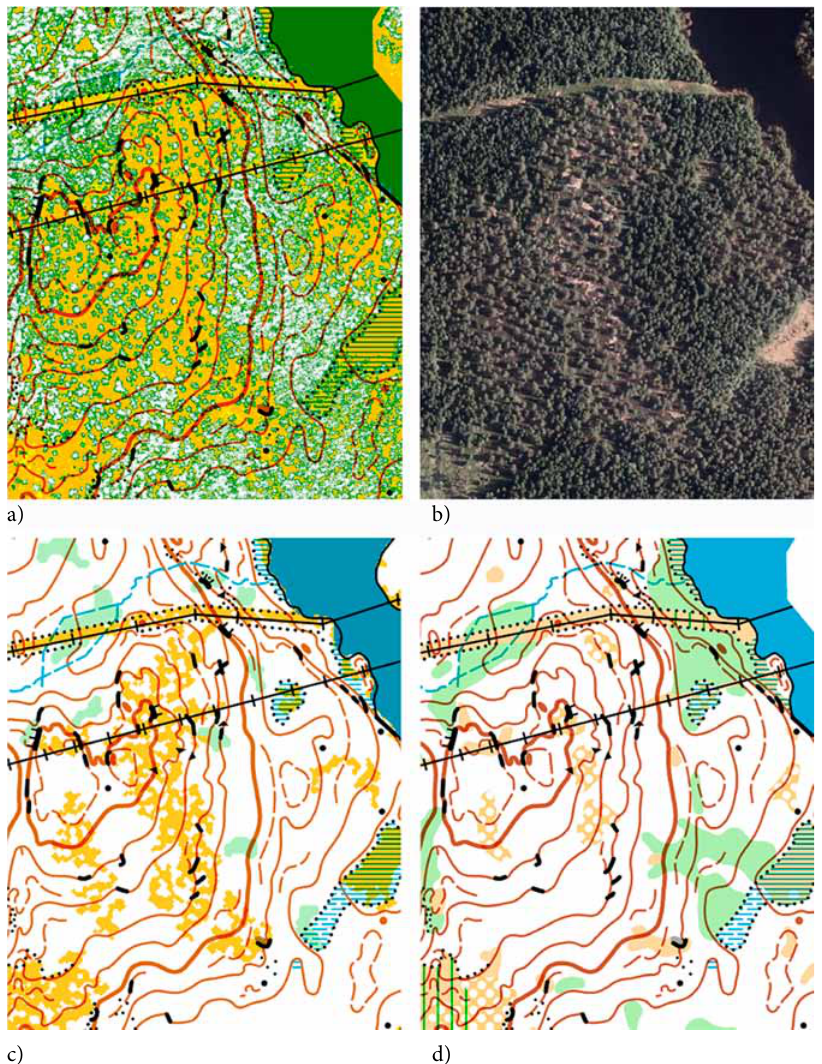
Fig. 11. The automatic method has mapped a larger area as ‘open with scattered trees’ than the manual survey. (a) Colour-coded vegetation height. (b) Air photo of